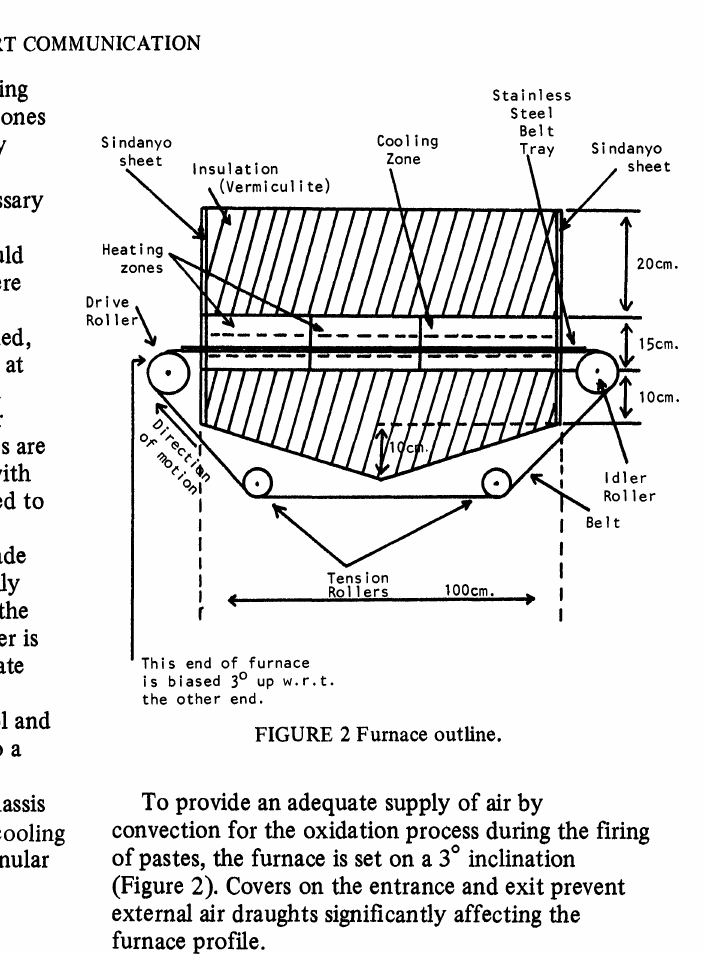
FIGURE 2 Furnace